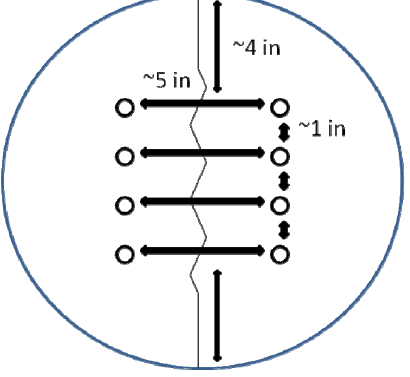
Figure 4. Denim sample layout for controlled bend: location of perforations for guide rods to control the number of